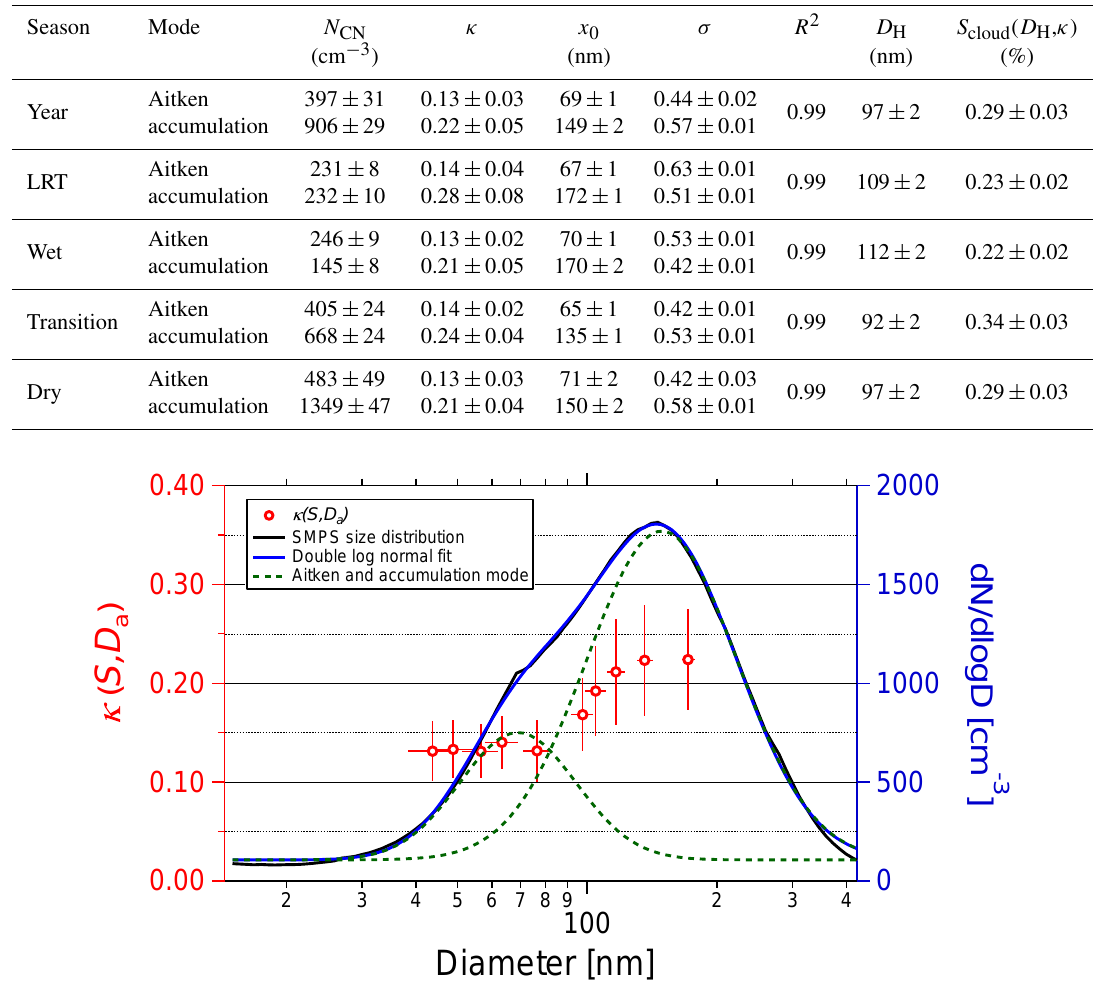
Figure 3. Size dependence of the hygroscopicity parameter κ ( S , D a ) averaged over the entire measurement period. Values of κ ( S , D a ) for every S level are plotted against their corresponding midpoint activation diameter D a ( S ) (left axis). For κ ( S , D a ) , the error bars represent 1 standard deviation. For D a ( S ), the experimentally derived error is shown. In addition, the average number size distribution for the entire measurement period is shown (right axis). Dashed green lines represent the average Aitken and accumulation modes. The standard error of the number size distribution is indicated as grey shading, which is very small and therefore hardly perceptible in this representation due to the large number of scans with comparatively small variability. Distinctly different κ ( S , D a ) levels can be observed for the Aitken and accumulation modes with lower variability in the Aitken than in the accumulation